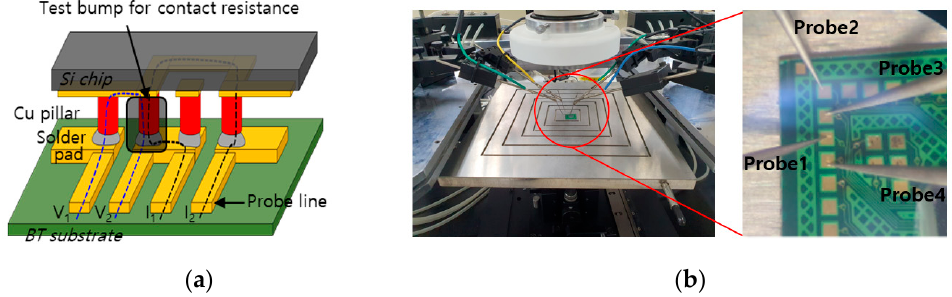
Figure 6. ( a ) Schematic of Kelvin structure for contact resistance measurement and ( b ) 4-point probe for the contact resistance measurement.